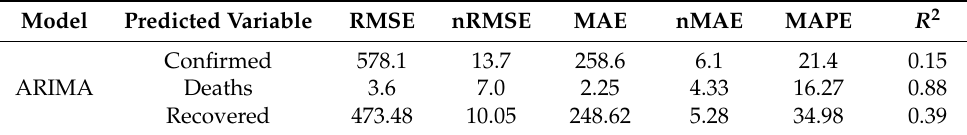
Table 2. Performance evaluation of the test dataset forecasting using the ARIMA model.